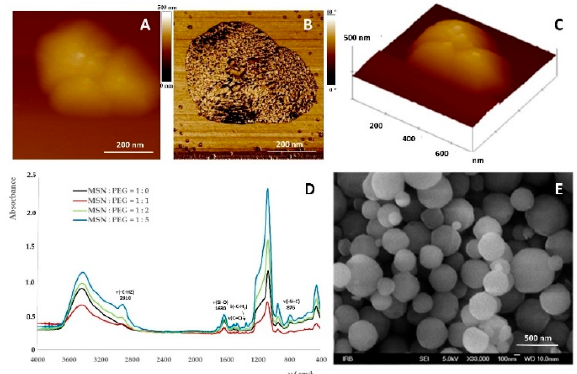
Figure 3. ( A ) Morphology of MSNs coated with PEG. Top view of the 2D atomic force microscopy (AFM) height image, vertical scale 500 nm, ( B ) phase image, vertical scale 80°, indicating PEG coatings on MSNs (white color on the MSNs), ( C ) 3D height image of an aggregate consisting of three MSNs, ( D ) FTIR spectra of pure MSNs (black); MSNs with PEG coating in weight ratio 1:1( red); 1:2 (green); 1:5 (blue), ( E ) FE-SEM micrograph of the PEG coated MSNs.